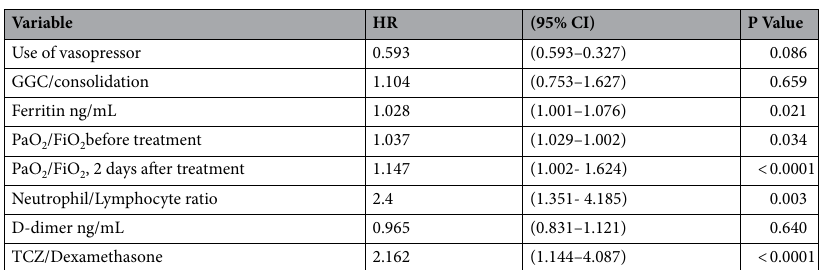
Table 2. Multivariable COX regression analysis of mortality in 109 critically ill COVID-19 patients. Abbreviations GGC: ground glass opacities; COPD: Chronic obstructive pulmonary disease; PaO 2 /FiO 2 : ratio of partial pressure of arterial oxygen over fraction of inspired oxygen TCZ: Tocilizumab; P ˂ 0.05 considered statistically significant.